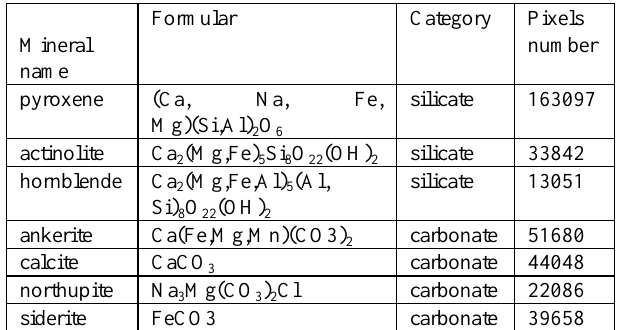
Figure 1. The mineral spectral angle map in Jezero Crater After a detailed classification from the CRISM hyperspectral image, several minerals are detected in this area. Pyroxene represented by the turquoise color is the main component in this area. Most of the Pyroxene distributes on the north part and sparse Pyroxene spreads in other regions. The Calcite and Ankerite are the majority of the rest minerals. Ankerite represented by red color mainly distributed centrally like a gradation band, which can be easily discriminated from each other. Calcite represented by the yellow color is existed as clustered in the southeast part. The Actinolite, Hornblende and Orthopyroxene are very rare with similar proportion, which indicates that few of them can be identified. The possibility of the Clinopyroxene is very low due to the extremely low proportion. These detected minerals as the decreasing order of pixels are pyroxene, ankerite, calcite, siderite, actinolite, northupite and hornblende, respectively. Table 1 shows the detailed minerals detected at Jezero Crater. The detailed abundance analysis is described in Figure 2.